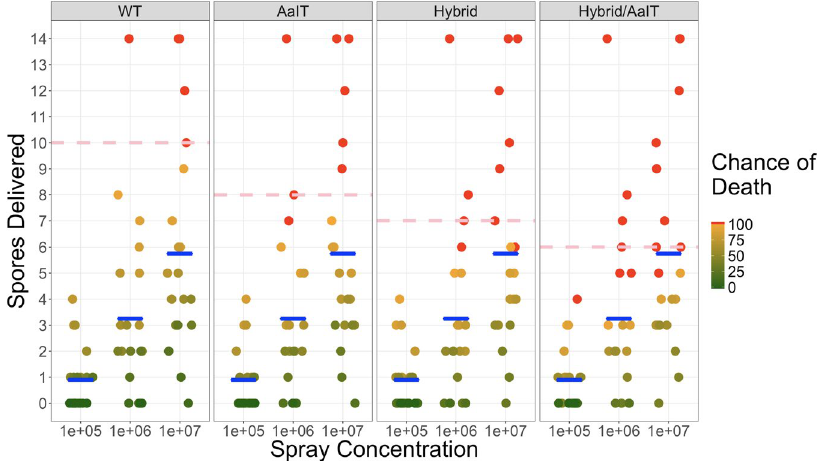
Figure 4. The number of spores infecting each mosquito after spraying with three different spore concentrations (1 × 10 5 , 1 × 10 6 , and 1 × 10 7 spores/mL in 0.01% Tween80) plotted against the probability of death. The mean number of spores delivered with each suspension is marked with a blue crossbar. Assuming that mosquitoes with a higher dose are more likely to die, we calculated the chance of death for each mosquito based on our survival data for each treatment at each concentration. Mosquitoes with an estimated 100% chance of death are colored in red, and 0–99% is represented with a green to orange gradient. The red dashed line indicates the estimated LD100 in each treatment (10 spores for WT, 8 spores for AaIT, 7 spores for Hybrid and 6 spores for